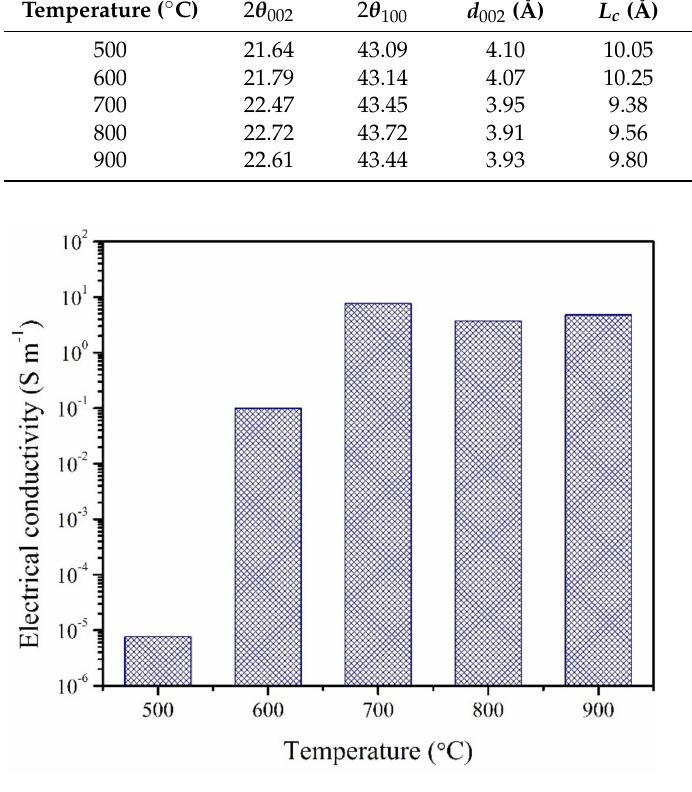
Figure 6. Electrical conductivity of CXs obtained at different carbonisation